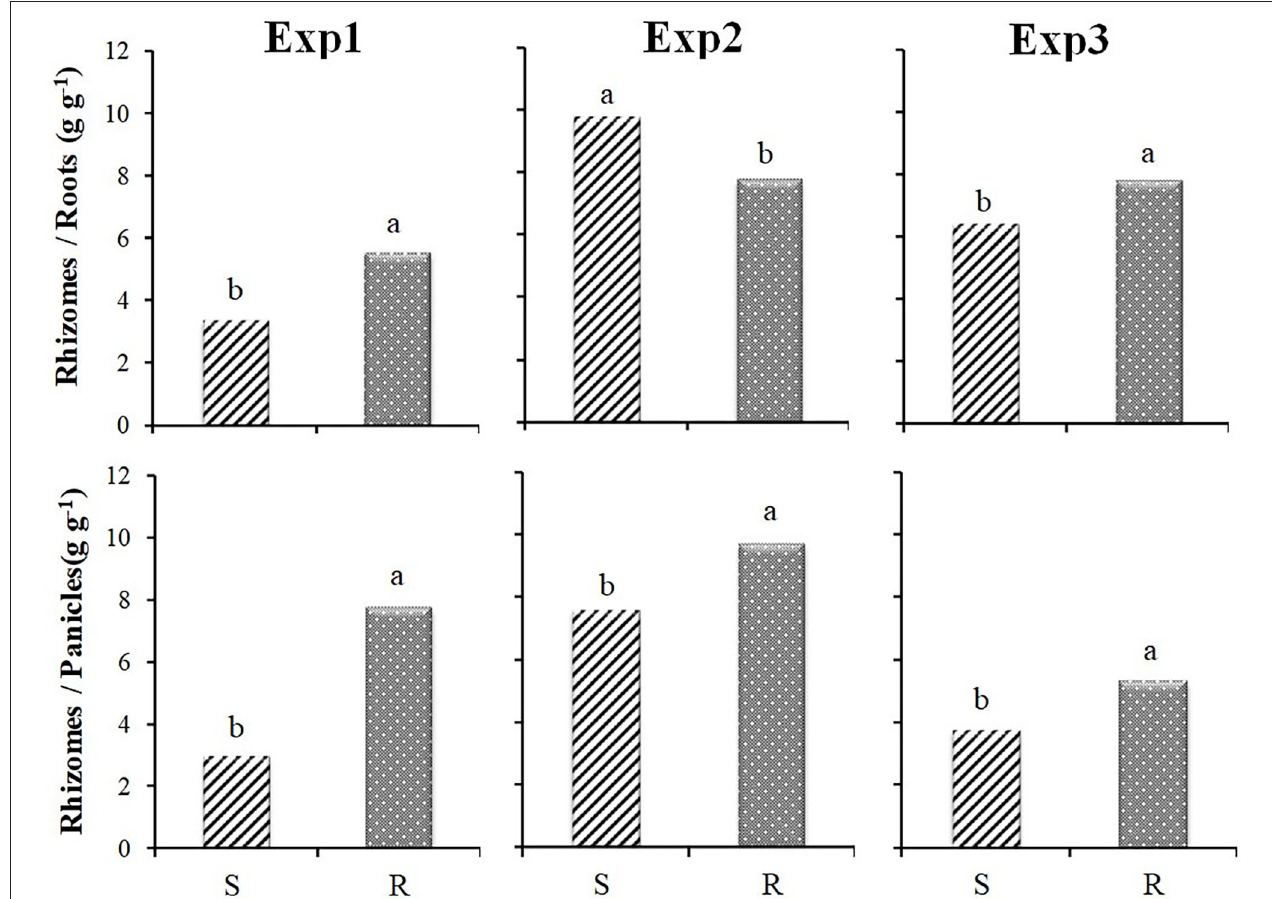
FIGURE 6 | Ratio between rhizome and root dry weight and between rhizome and panicle dry weight for the three experiments in relation to the resistance status (S and R ). Different letters indicate significant differences ( P ≤ 0.05) according to Fisher’s LSD test.